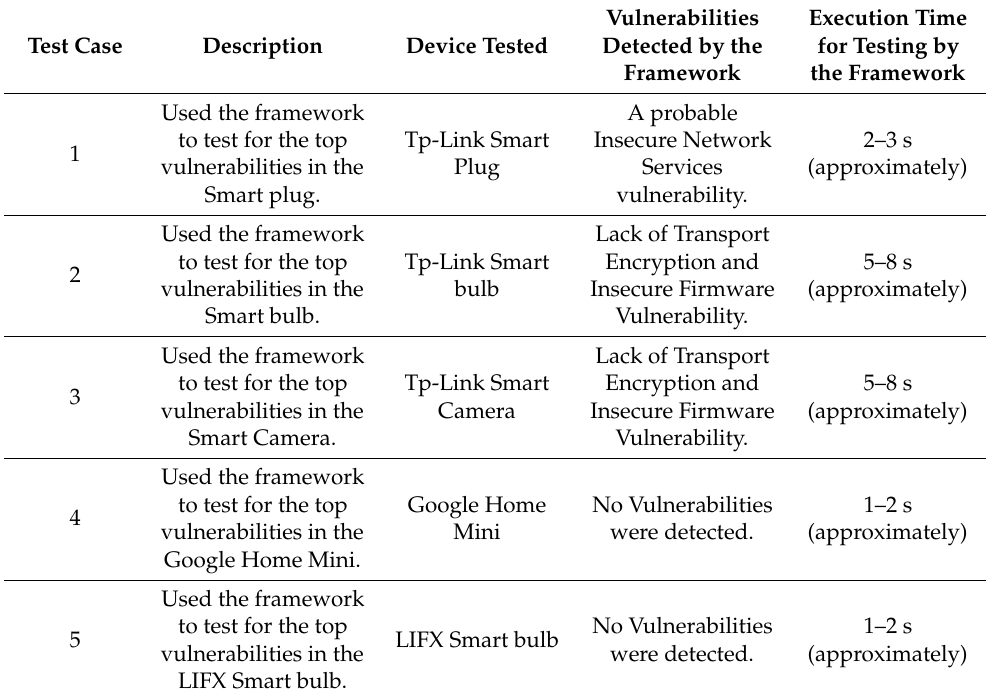
Table 1. Results of